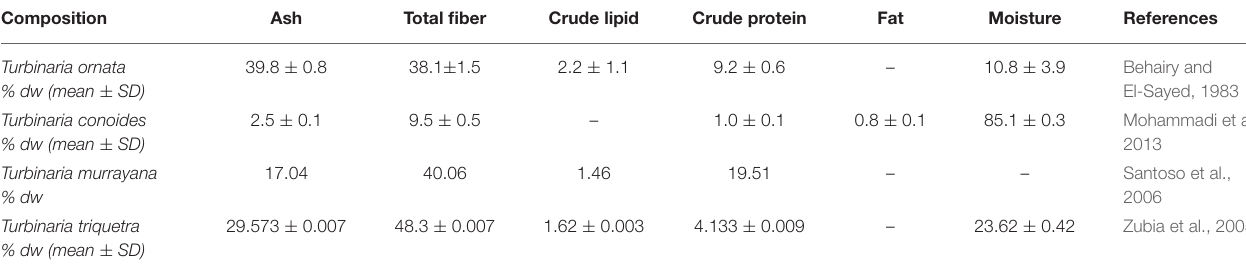
TABLE 3 | Proximate composition of various Turbinaria